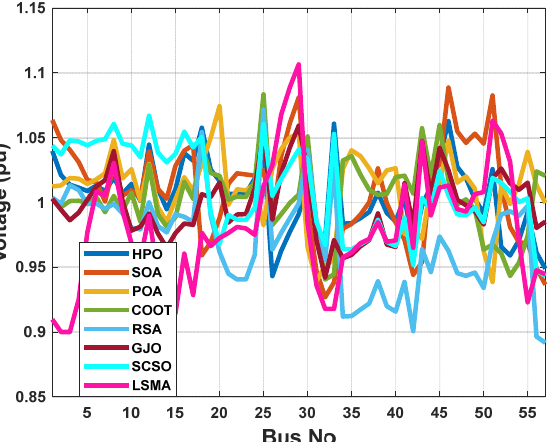
Figure 28. The voltage profile of the POA and other compared algorithms for case 5 in a standard IEEE 57-bus test system.